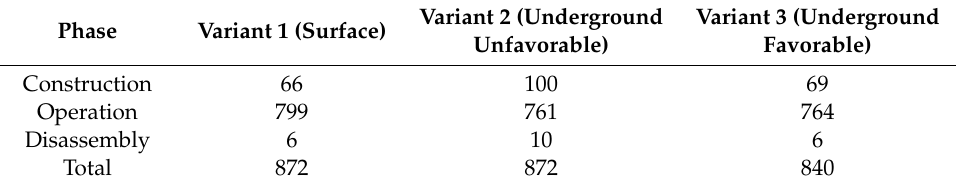
Table 2. Savings incurred during the construction phase (in MJ / m 2 / yr).